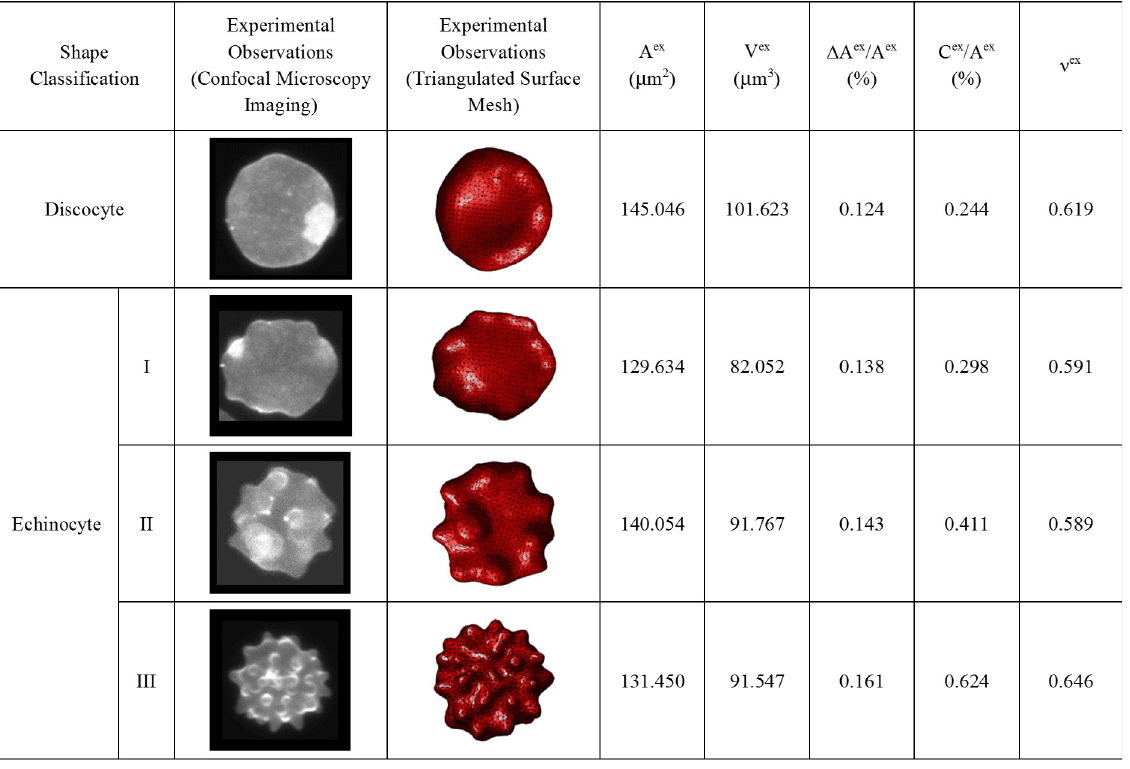
Fig 4. Summary of estimated cell surface area ð A ex Þ , cell volume ð V ex Þ , bilayer-leaflet-area-difference ð Δ A ex Þ , total-membrane-curvature ð C ex Þ and equivalent reduced cell volume ð ν ex Þ for the experimentally observed discocyte, echinocyte I, echinocyte II and echinocyte III RBC shapes.